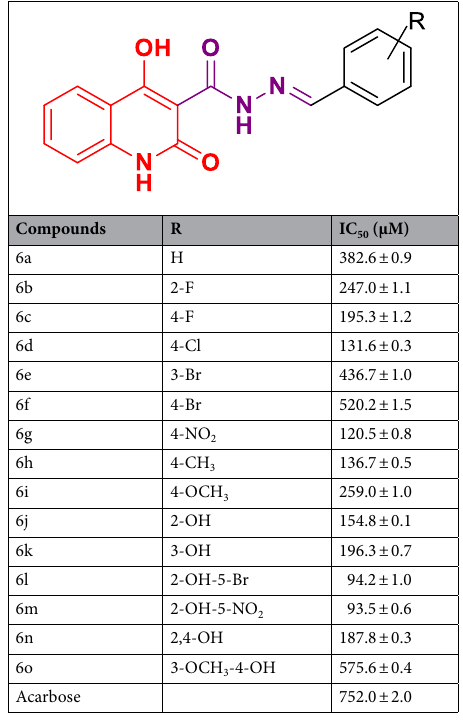
Table 1. α-Glucosidase inhibition of 4-hydroxyquinolinone hydrazone hybrids a . a Data represented in terms of mean ± SD.